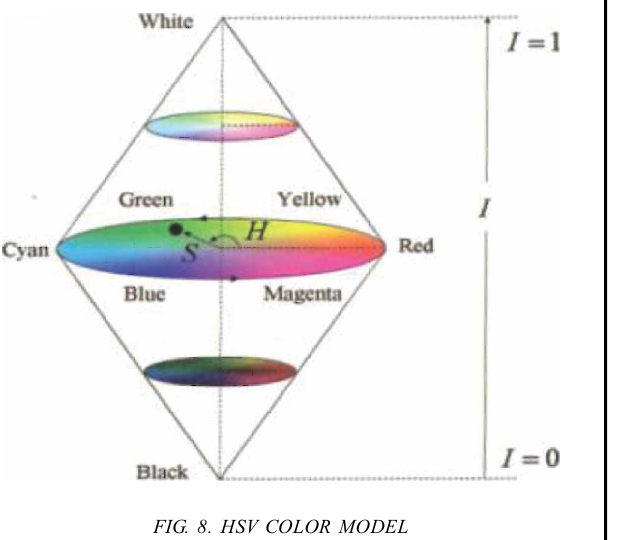
FIG. 8. HSV COLOR MODEL FIG. 9. IMAGES OF DIFFERENT STEPS IN VISION